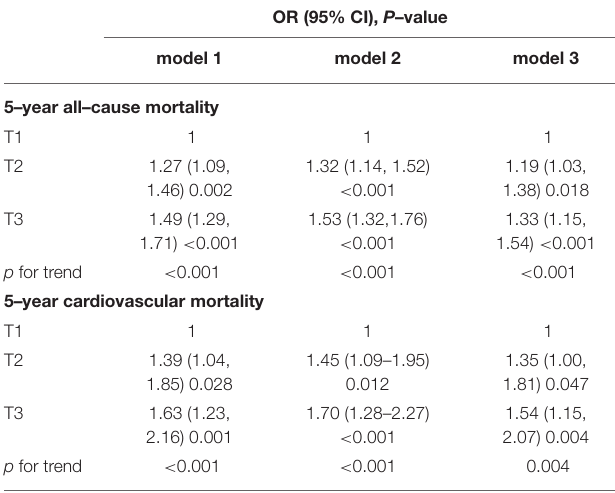
TABLE 2 | Associations between the E-DII and mortality among CKD patients aged ≥ 20 years